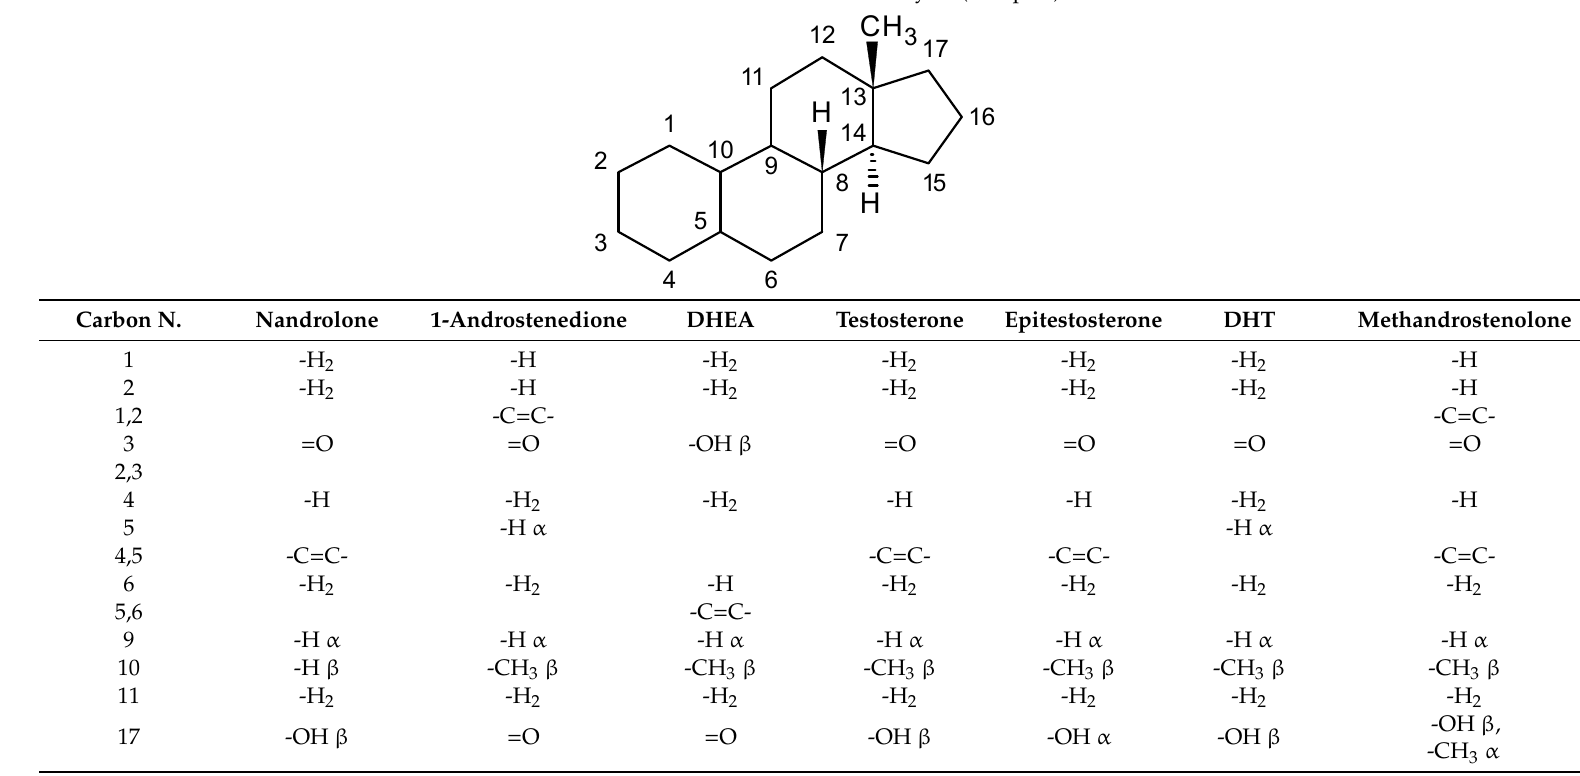
Table 1. Chemical structures of the analytes (first part).